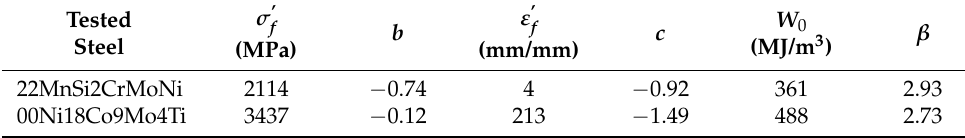
Table 3. Parameter values of LCF test for 22MnSi2CrMoNi and 00Ni18Co9Mo4Ti steel.